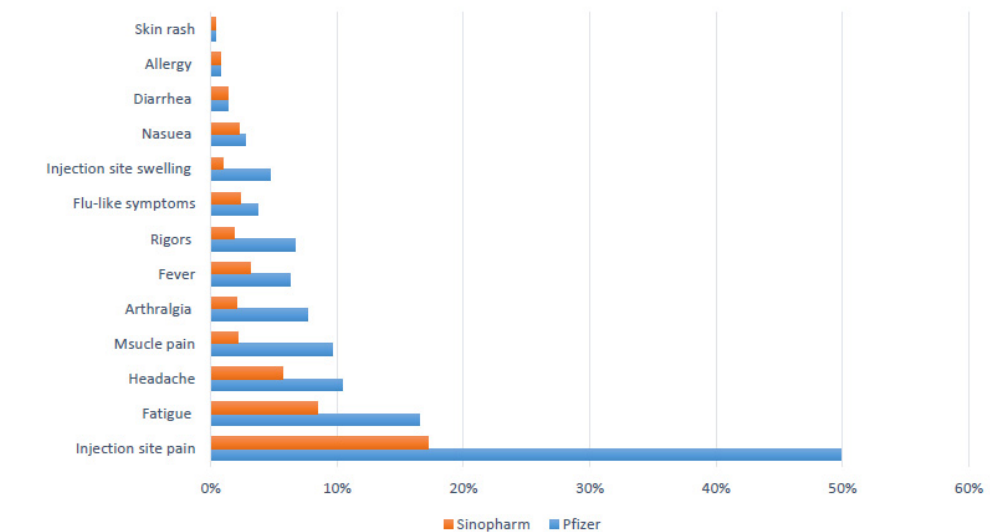
Figure 3. The frequency of adverse reactions after the first dose of COVID 19 vaccine.